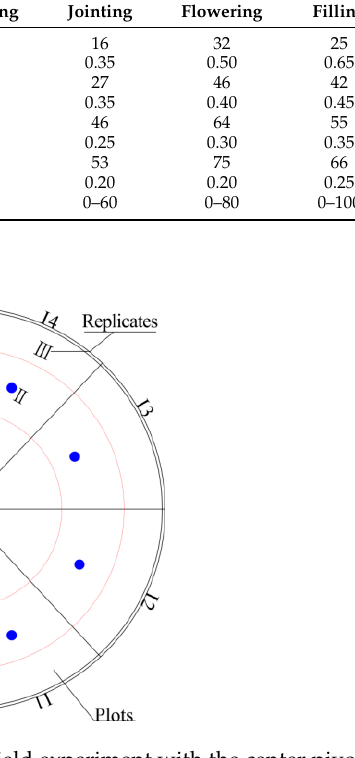
Table 1. Irrigation quota (mm) of different treatments for wheat and maize in the 2019–2020 growing season. Treatments